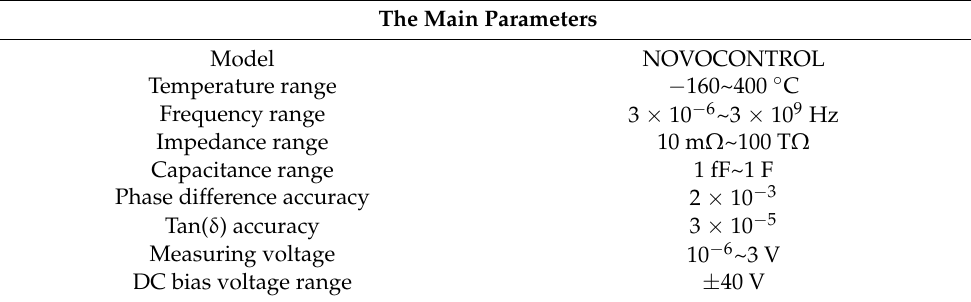
Table 3. Equipment data sheet for Novocontrol broadband dielectric spectrometer.